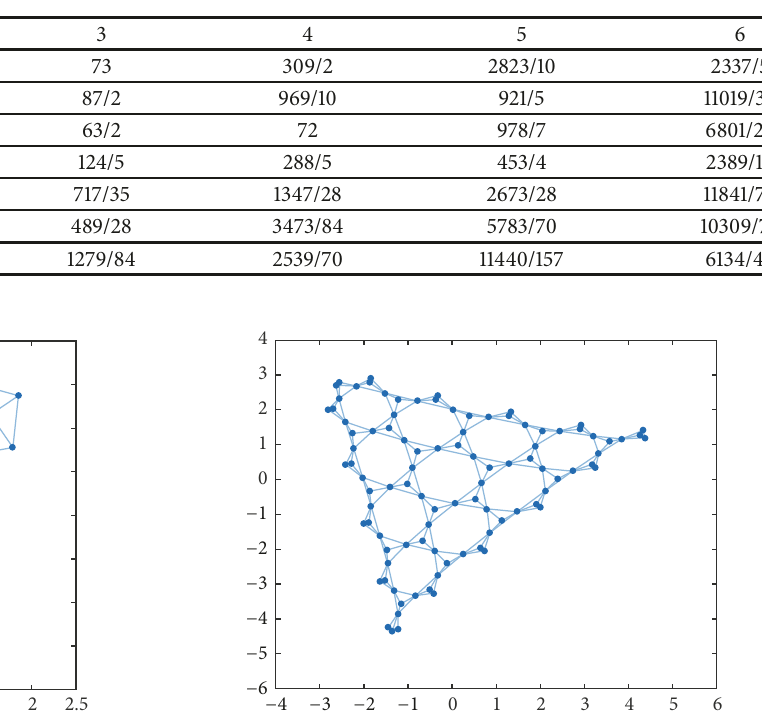
Figure 12: Regular triangular silicate network